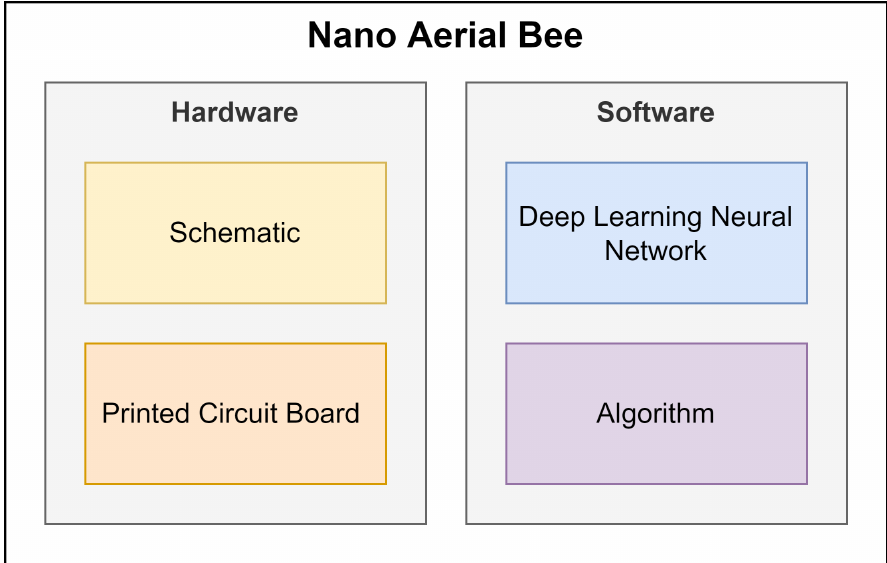
Figure 1. Categories of developed